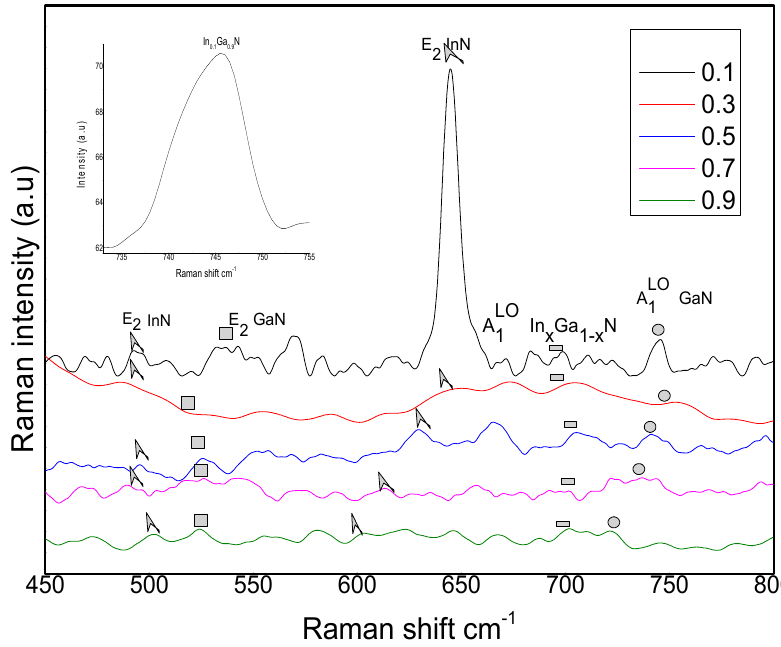
Figure 8. Raman spectroscopy of In x Ga 1 − x N thin film prepared by TVE at di ff erent x ratios.